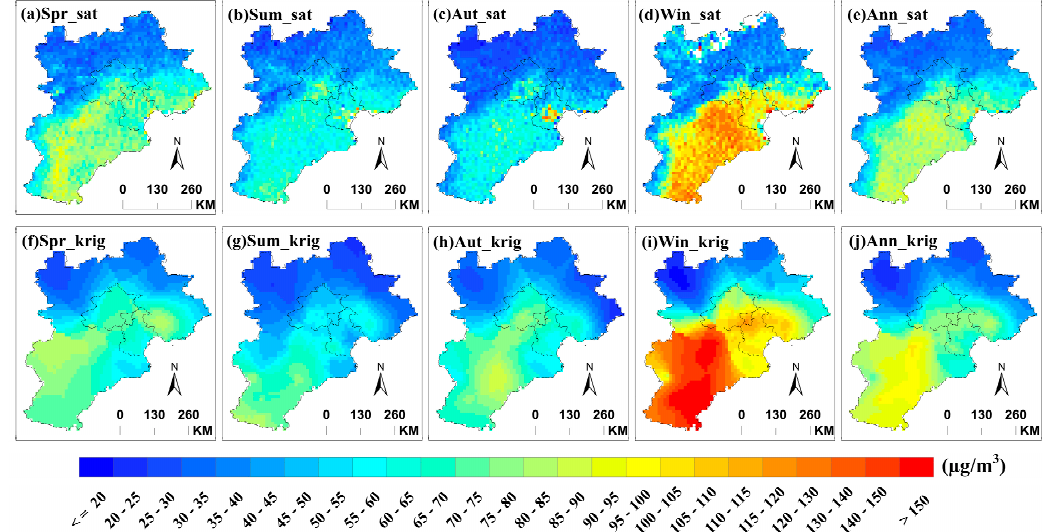
Figure 5. PM 2.5 concentration prediction maps based on RF invention ( a – e ) and kriging interpolation ( f – j ). Spr, Sum, Aut, Win, and Ann represent spring, summer, autumn, winter, and the whole year, respectively.